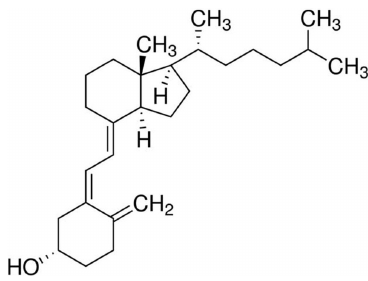
Figure 1. The chemical structure of the vitamin D3. Table 1. Chemical composition (wt %) of titanium c.p. grade 2 [20].